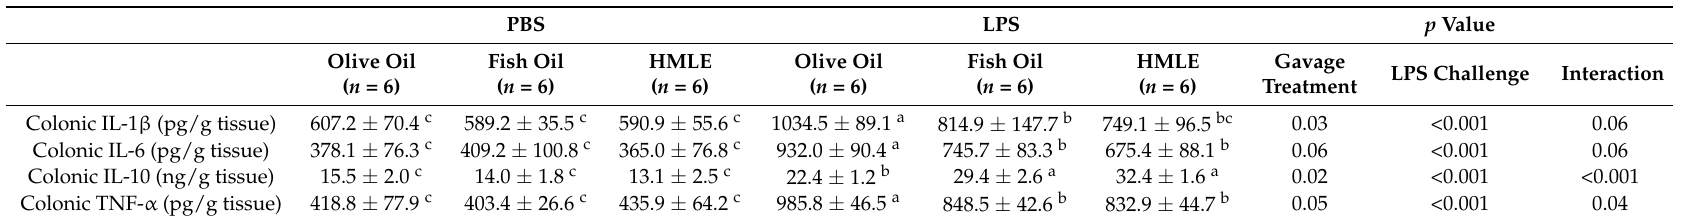
Table 4. Effects of different gavage treatments on colonic cytokines